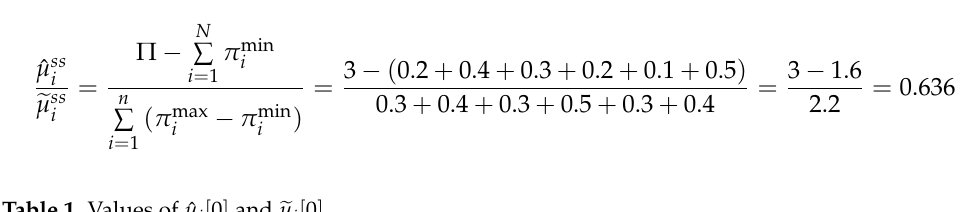
Table 1. Values of ˆ µ i [ 0 ] and (cid:101) µ i [ 0 ] .